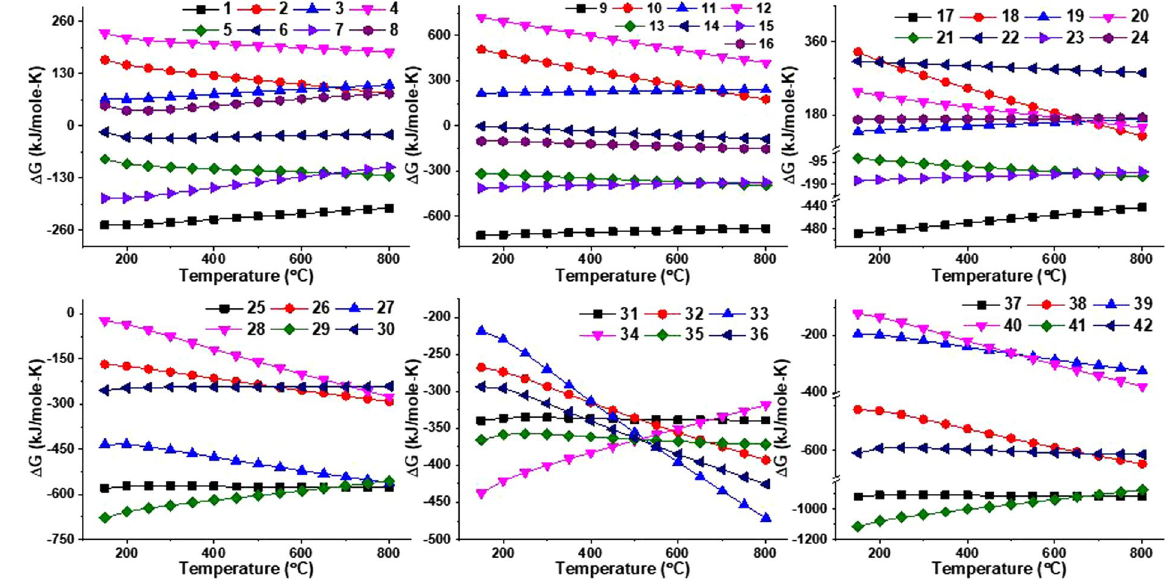
Figure 6. Feasibility and non-feasibility of possible reaction paths to form NbC from Nb 2 O 5 via multi-step route.